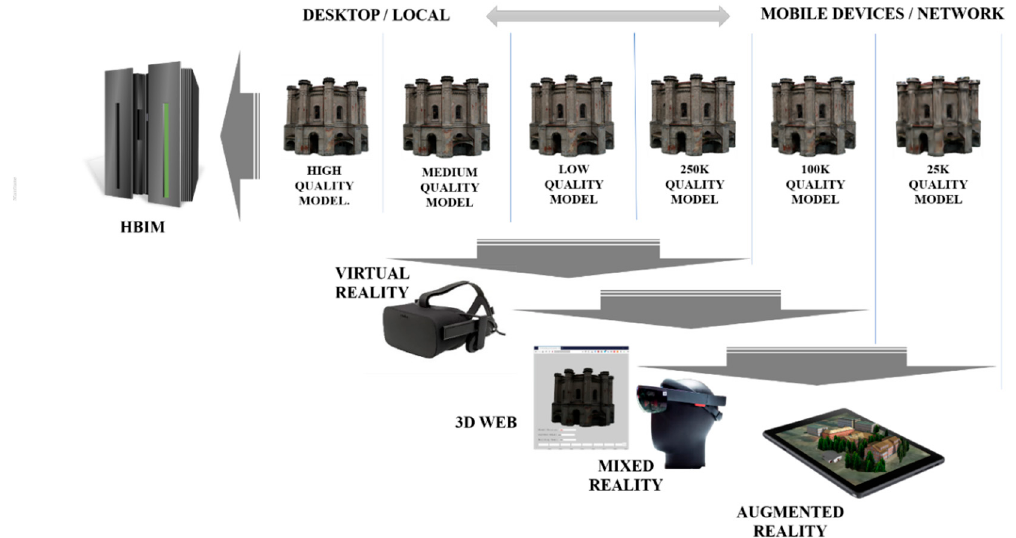
Figure 12. Visual illustration of the strategy of generating mesh models.